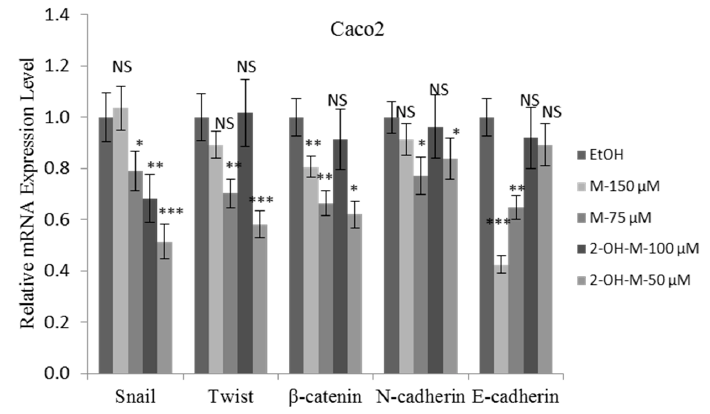
Figure 5. mRNA expression of Epithelial–mesenchymal transition (EMT) markers upon treatment with sub-lethal concentrations of melatonin or 2-hydroxymelatonin. Quantitative analysis of the mRNA levels of EMT markers in Caco2 cells treated with melatonin or 2-hydroxymelatonin dissolved in ethanol for 24 h. Data represent mean ± standard error of the mean, n = 3. * p < 0.05; ** p < 0.01; *** p < 0.001; NS, no significant difference compared with the ethanol-treated group. EtOH, ethanol; M, melatonin; 2-OH-M, 2-hydroxymelatonin.